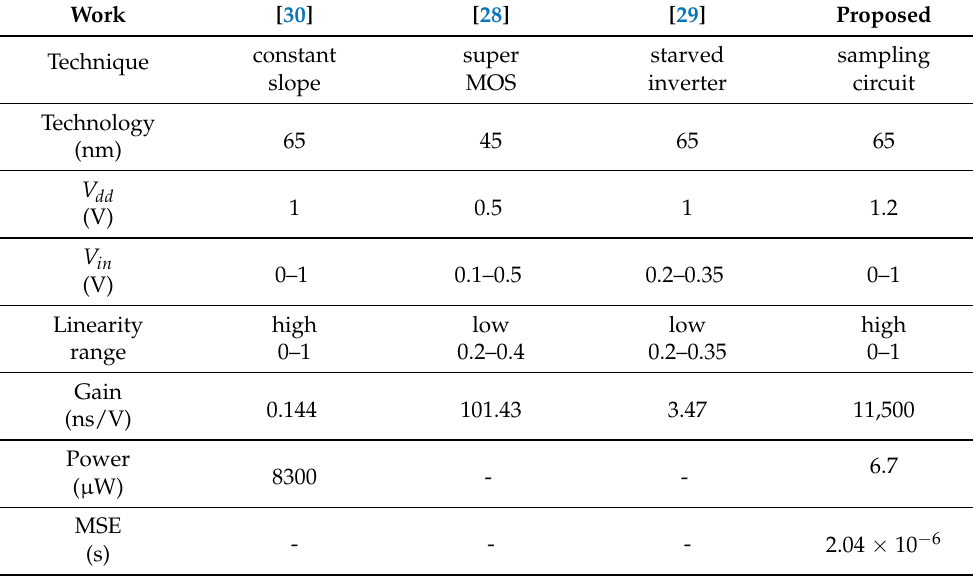
Table 2. Comparison between proposed and prior